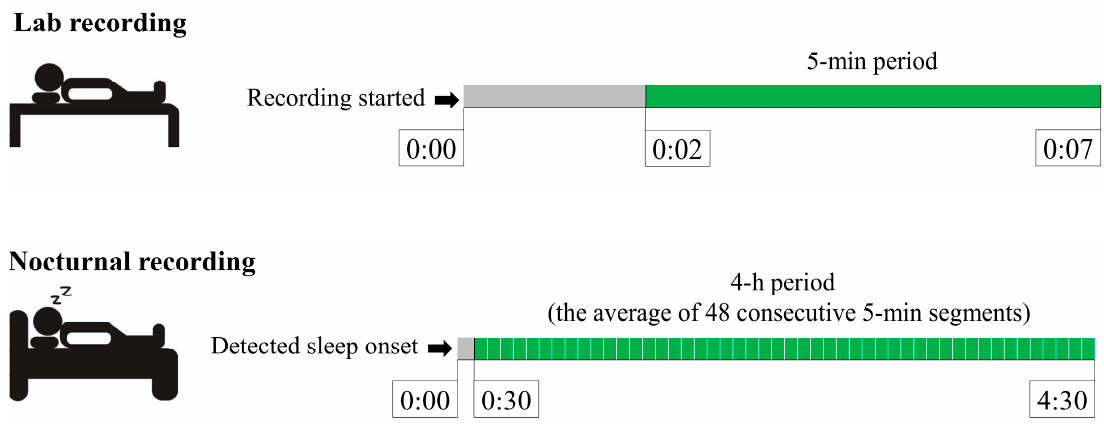
Figure 1. Segments used in the analysis of laboratory and nocturnal